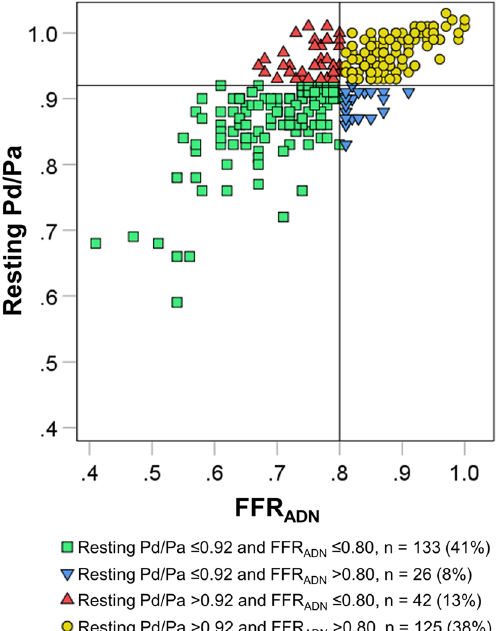
Figure 1. Scatter plot of resting Pd/Pa and FFR ADN . The vessels were classified into four groups by using the predefined cut-off values of 0.92 for resting Pd/Pa and 0.80 for FFR ADN . Among 326 vessels, 68 (21%) demonstrated discordance: low resting Pd/Pa–high FFR ADN in 26 vessels (8%) and high Pd/Pa–low FFR ADN in 42 vessels (13%). FFR ADN fractional flow reserve value associated with adenosine, Pd/Pa distal-to-aortic pressure